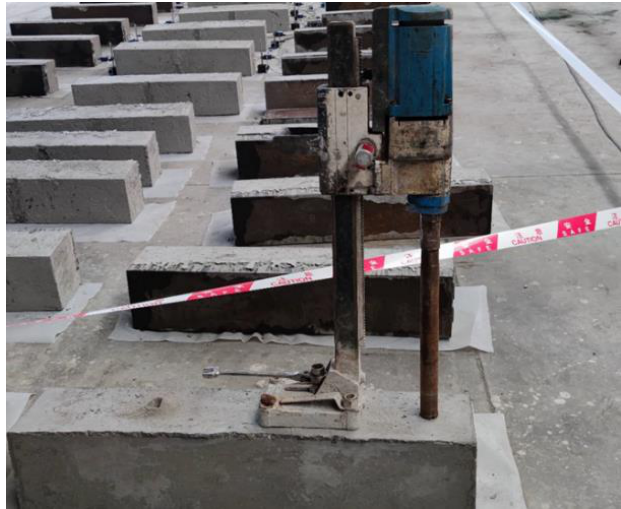
Figure 5. Core sampling method.